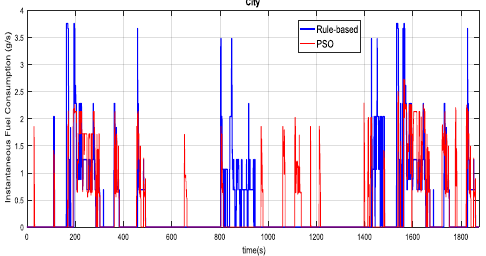
Figure 10. Comparison of instantaneous fuel consumption in the urban driving